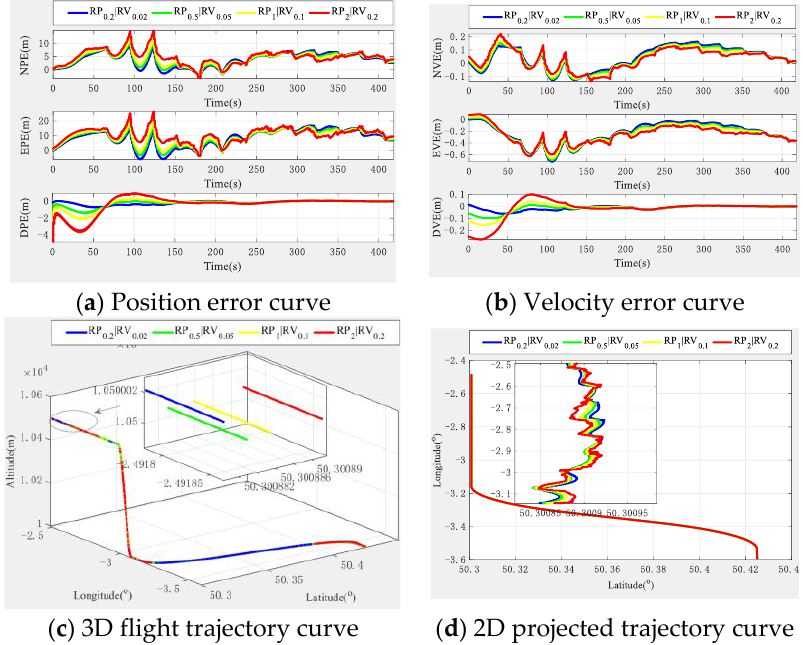
Figure 12. Navigation positioning error curves under different relative measurement accuracy.